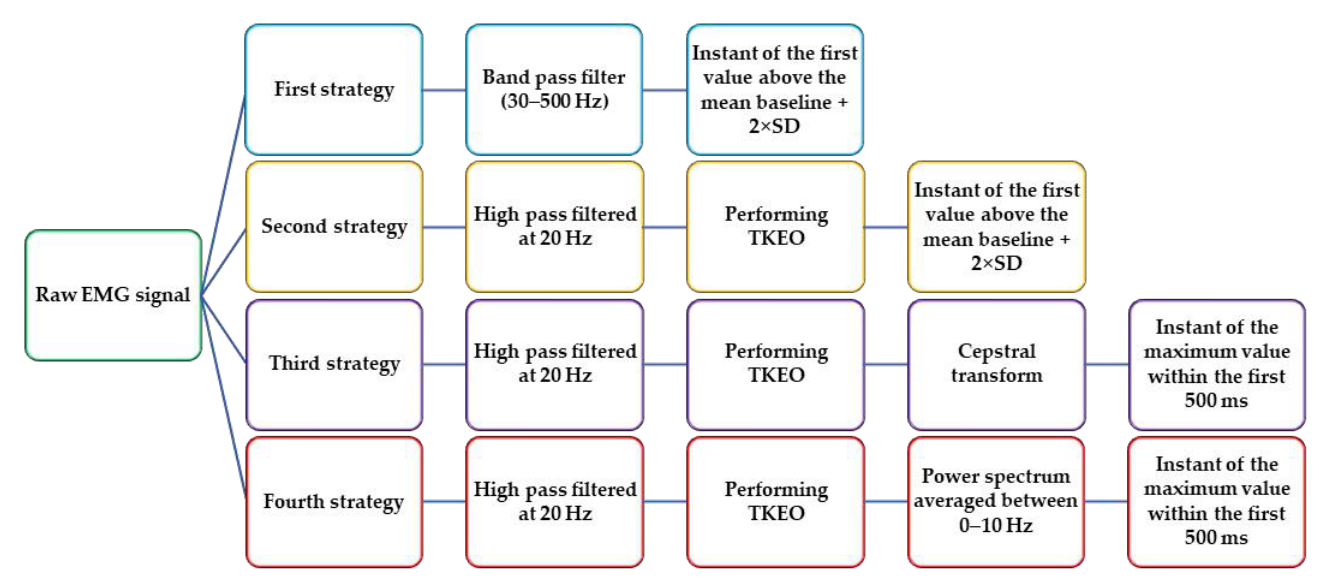
Figure 2. Flow chart of all four strategies used for time delay